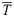
HIV/HPV dynamics under chronic HPV at the start of cART.(a) HPV W; (b) CD4+ T cells T as given by model (5) under cART. Here, ε = 0.5 per day, εRT = 0.95, εPI = 0.5, and all other parameters are listed in Table 1. Initial conditions are T0 = 3.3x105 cells per ml; I0 = 2.4x105 cells per ml; V0 = 4.8x104 virions per ml; Y10 = 3.2x103 cells; Y20 = 1.6 x104 cells; W0 = 1.8x107 virions; E0 = 0.01 cells, and t = 0 is the start of cART. Moreover, we found two instances when HPV infection stays chronic in the presence of cART, namely strong drug efficacy, εRT = 0.95 and εPI = 0.5, and AIDS level CD4+ T cells, T¯ ≤ 1.7×105 cells per ml; and, inefficient drug therapy, εRT = 0.2 and εPI = 0 and intermediate CD4+ T cell levels T¯ ≤ 2.6×105 cells per ml.